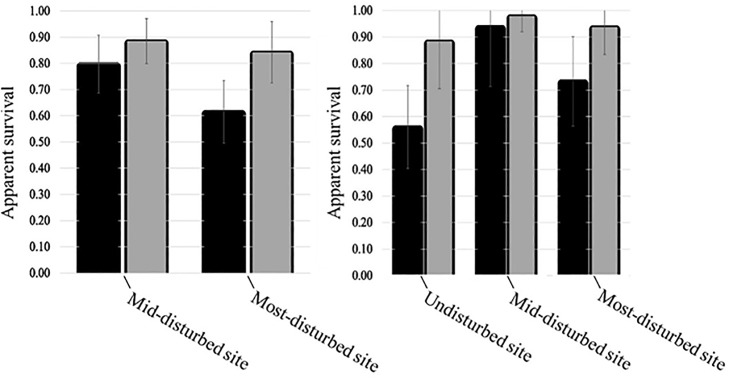
Site-specific apparent survival estimates (± unconditional SE).(left) CACH survival estimates, and (right) TUTI survival estimates. The darker shaded bar represents non-breeding season and the lighter color bar represents breeding season in each graph. Note: no survival estimates are available for CACH at the undisturbed site.